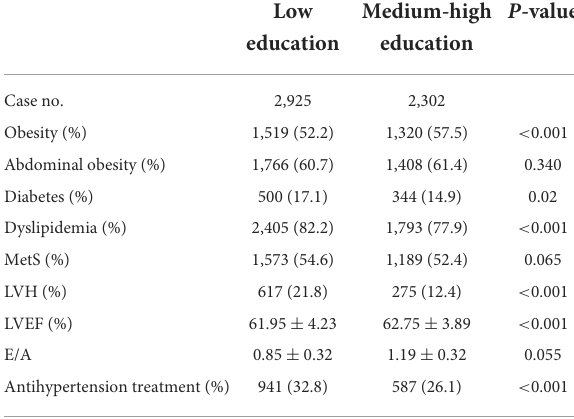
TABLE 1 Clinical characteristics in hypertensive subdivided at baseline according to educational status.